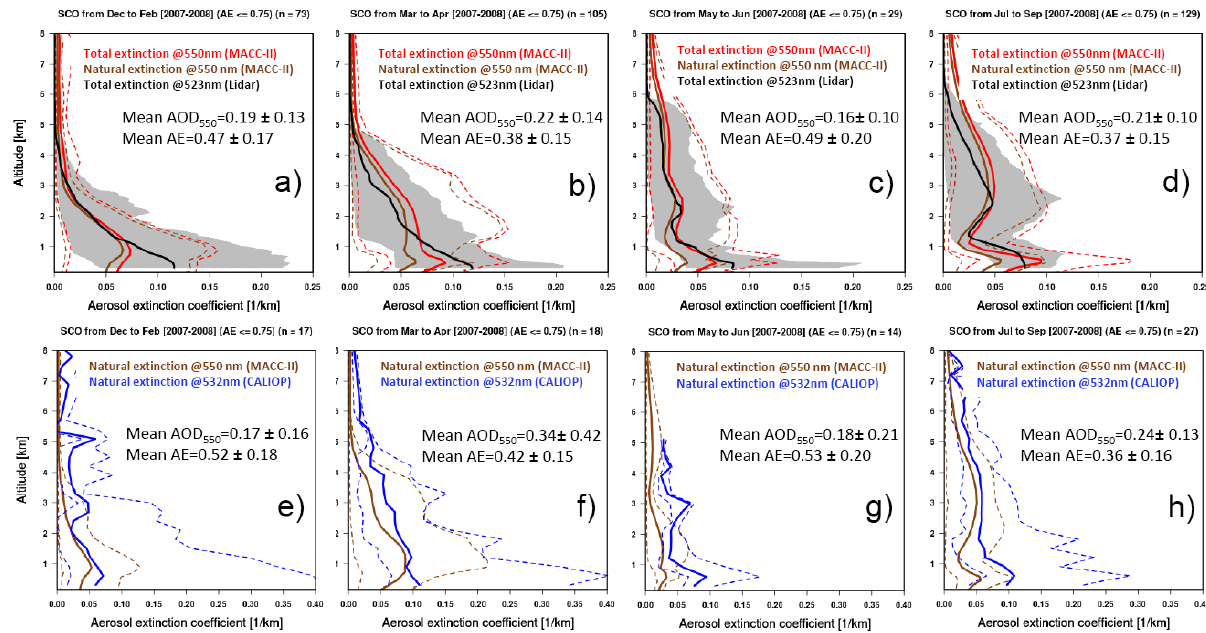
Figure 9. The same as Fig. 8 but for SCO station, and corresponding periods, where AE < 0 . 75 was used, instead < 0 . 35, to select dust